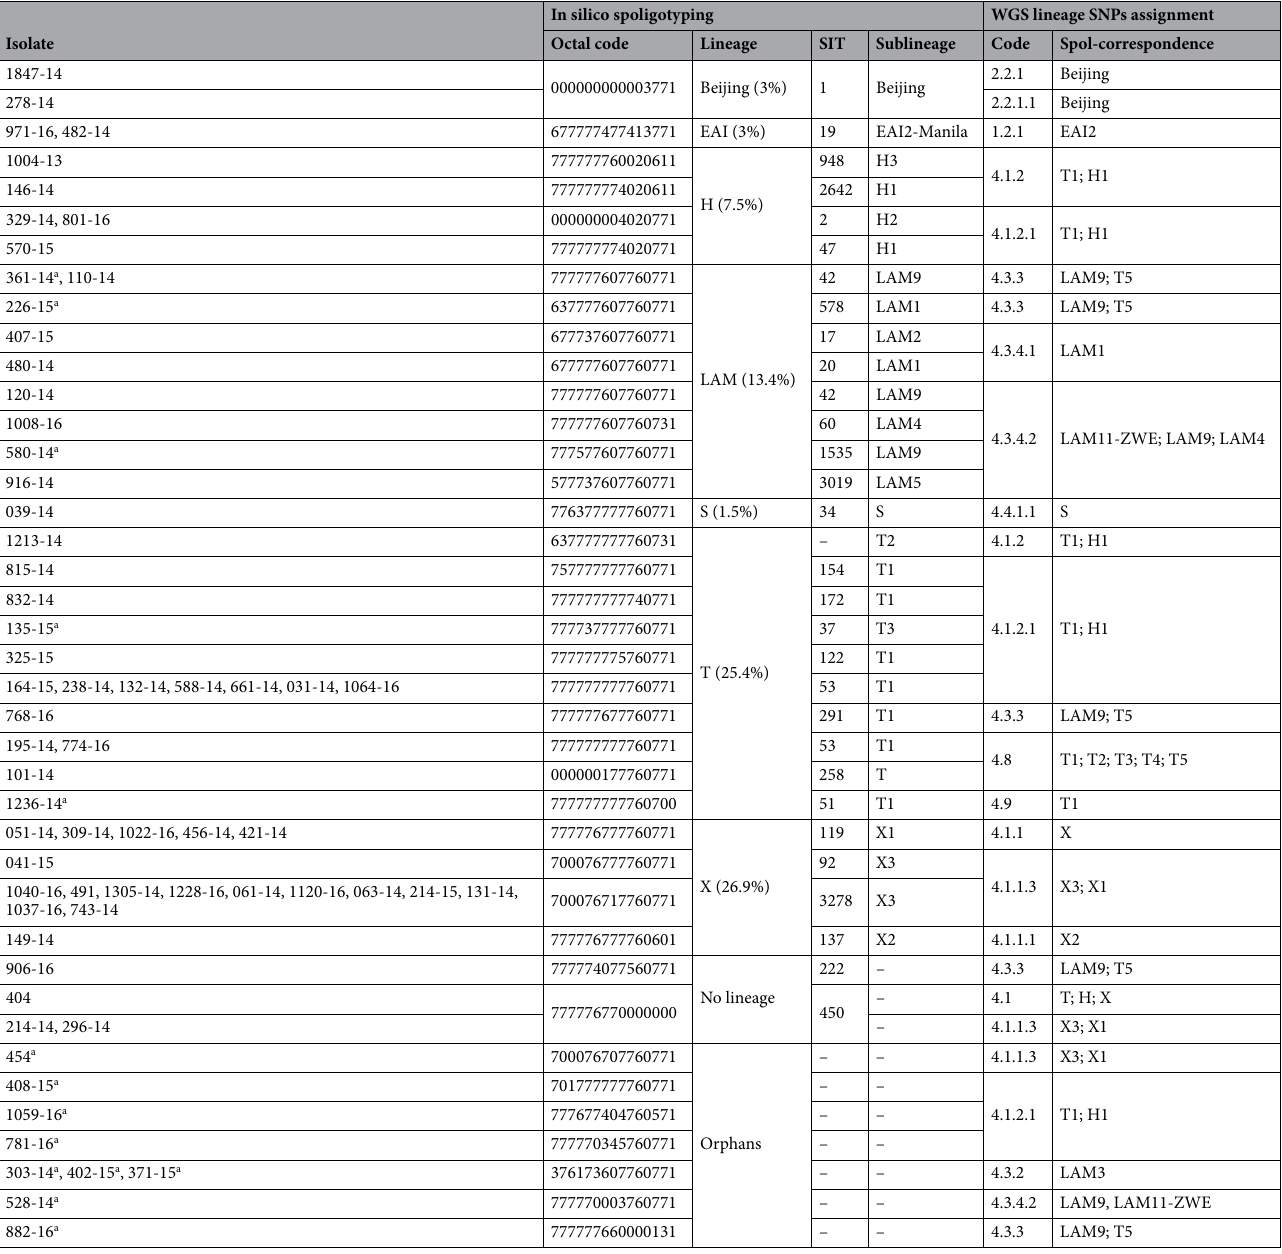
Table 2. Genotypic characterization by in silico spoligotyping and phylogenetic variants of DR-TB circulating in Veracruz, Mexico. a Described for the first time in